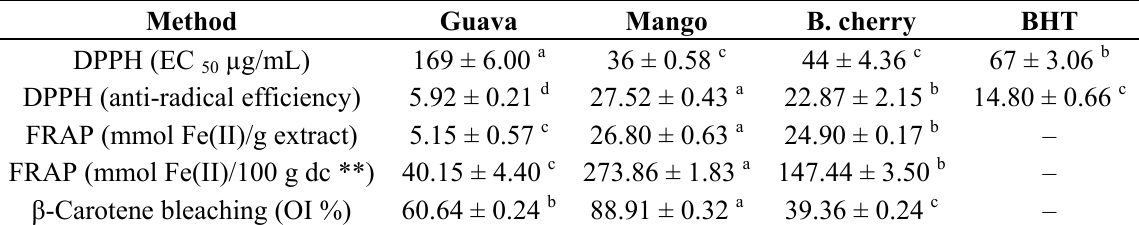
Table 2. Antioxidant activity in ethanolic extracts of fruits co-products *.